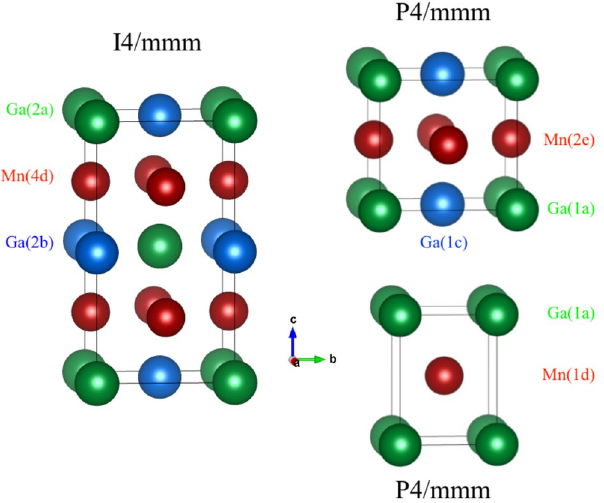
Figure 1. The three tetragonal structures considered here for the Mn x Ga system and drawn for stoichiometric MnGa for simplicity. Anti-clockwise from top right: Large cell P4/ mmm (#123, often denoted as L 1 0 ) generally assumed for MnGa, has two Ga sites and one Mn site; I4/ mmm (#139, or D 0 22 ) generally assumed for Mn 3 Ga, constructed by stacking two P4/ mmm cells along the c -axis; The simpler reduced-cell P4/ mmm structure proposed here with one Ga and one Mn site. It is a simplified form of the larger L 1 0 –P4/ mmm cell with c unchanged and a ′ = 2 . In each case the atom sites are identified next to each